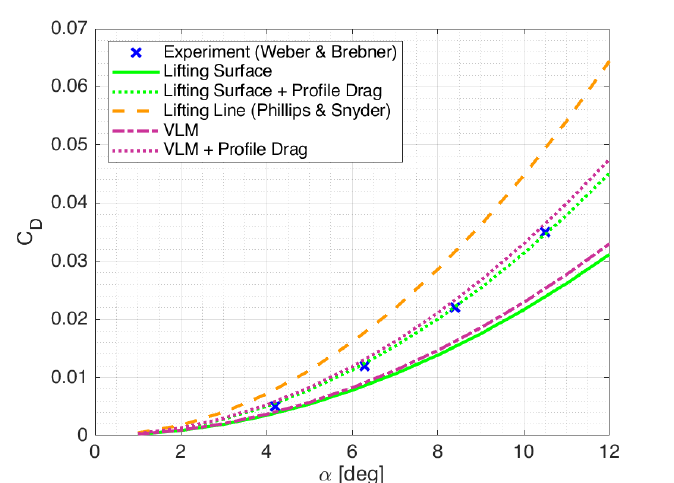
Figure A4. Drag prediction comparison. Compared to the experimental data, the modified LLT predicts higher induced drag than the total drag measured in the experiment. The LS and VLM models appear to under predict the total drag compared to the experiment. This is expected as they only evaluate the induced drag component. As such, when adding the profile drag contribution of the RAE101 aerofoil used for the experiment, the predicted drag coefficient is in good agreement for the LS model, and is slightly over predicted for the VLM